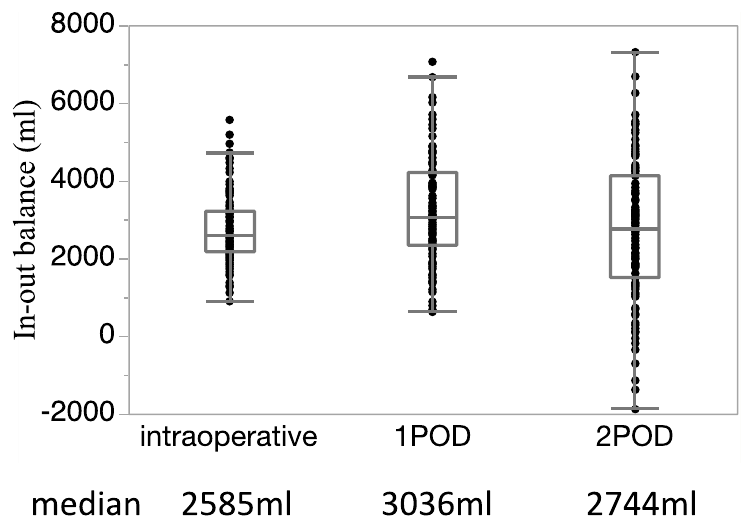
Figure 1. Perioperative fluid balance from during surgery to postoperative day 2. The median fluid balance during surgery, at POD 1, and POD 2, were 2585 mL, 3036 mL, and 2744, respectively.